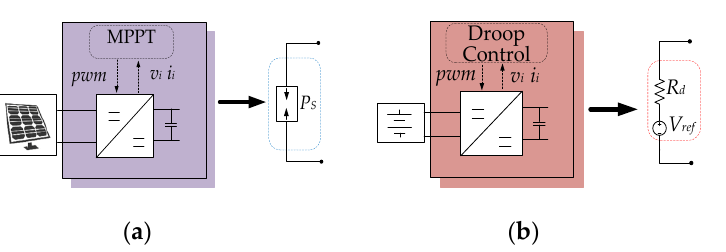
Figure 2. Distributed Resources model. ( a ) Maximum Power Point Tracking (MPPT) control. ( b ) Droop control.